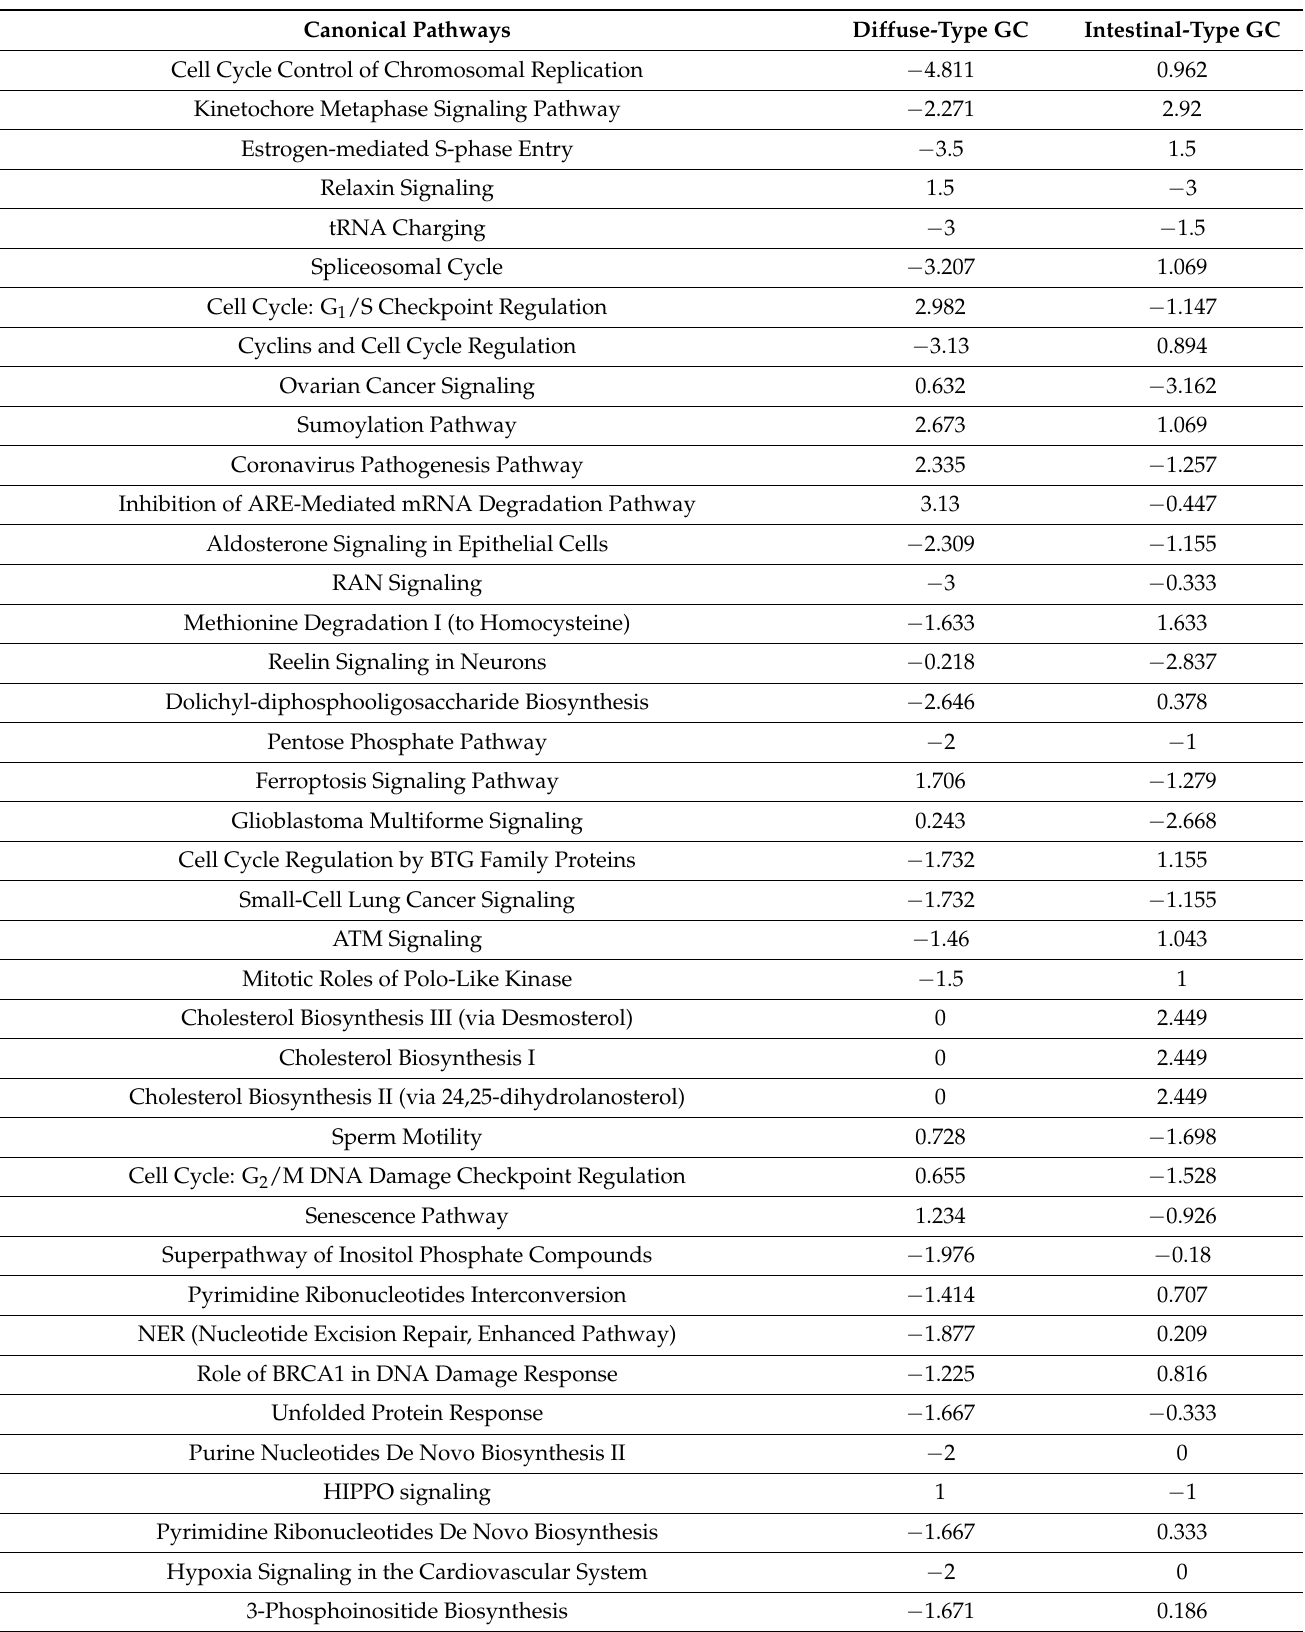
Table 1. Canonical pathways altered in diffuse- and intestinal-type GC. The pathways are sorted in the order of the activation